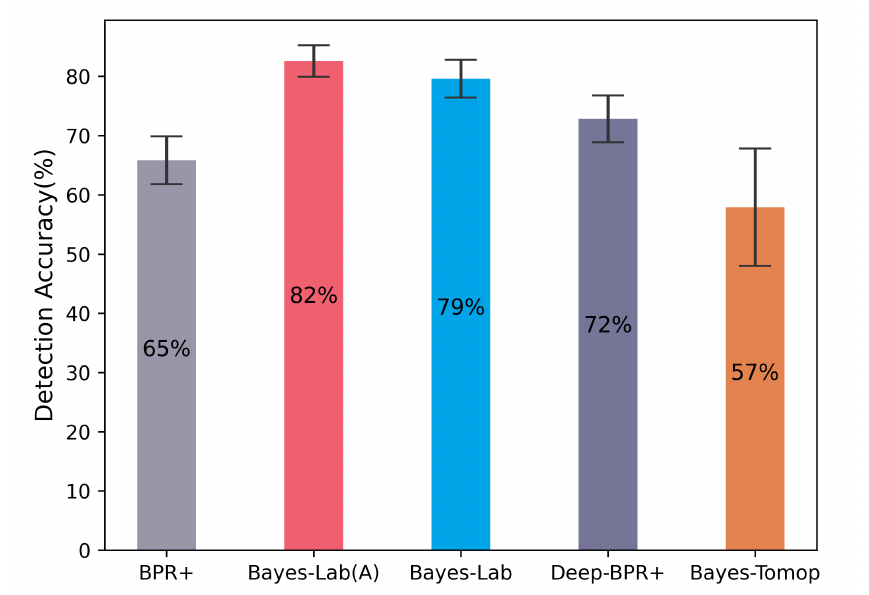
Figure 10. The detection accuracy against non-stationary